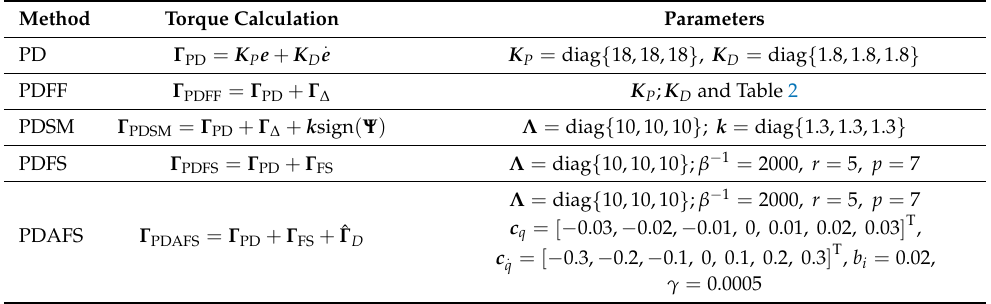
Table 5. The parameters of the proposed controller and compared controllers in